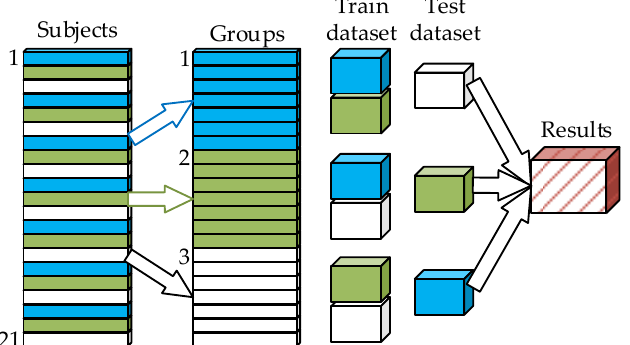
Figure 6. Database organization for the purpose of the ANN training and the cross-validation. The dataset was divided into three equal subsets and two subsets were used for training, while the remaining subset was used for testing. This process was repeated for all the combinations of the subsets in the training set. The three training datasets comprised 3473, 3429 and 3386 heartbeats, while the three testing datasets comprised 1671, 1715 and 1758 heartbeats.